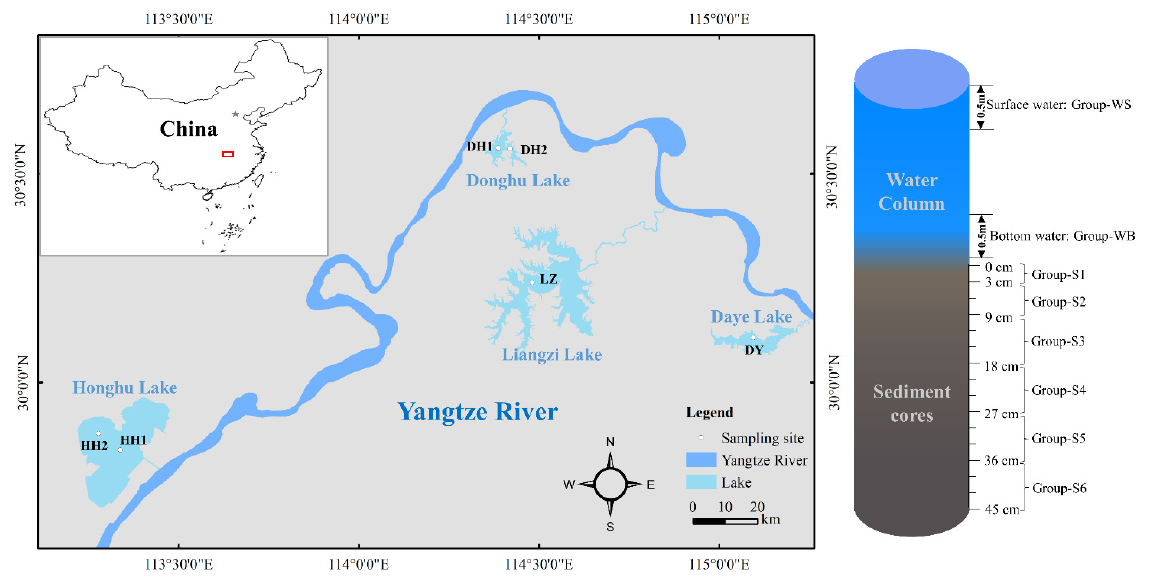
Figure 1. Spatial distribution and vertical profile of sampling sites. The red box represents the study